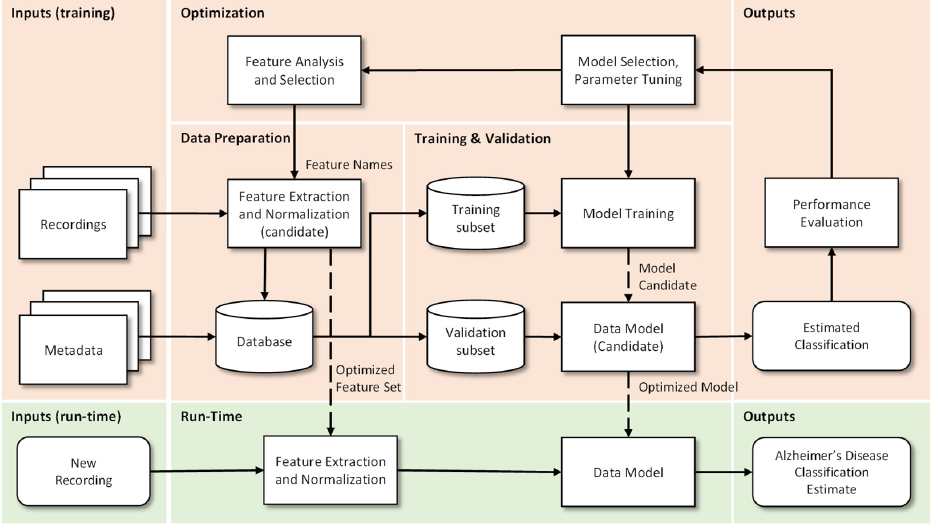
Figure 3. Flowchart of a general machine learning pipeline to process acoustic/prosodic correlates of disease. Adapted from Braga et al. [31].